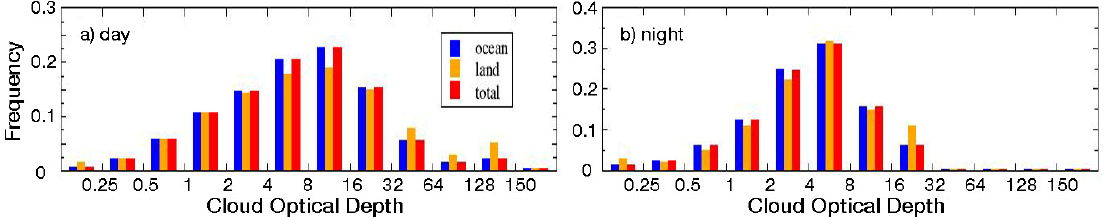
Figure 14. Frequency of occurrence of CV1S COD for liquid water clouds, 2012, 30 ◦ S–60 ◦ S, ( a ) day and ( b )